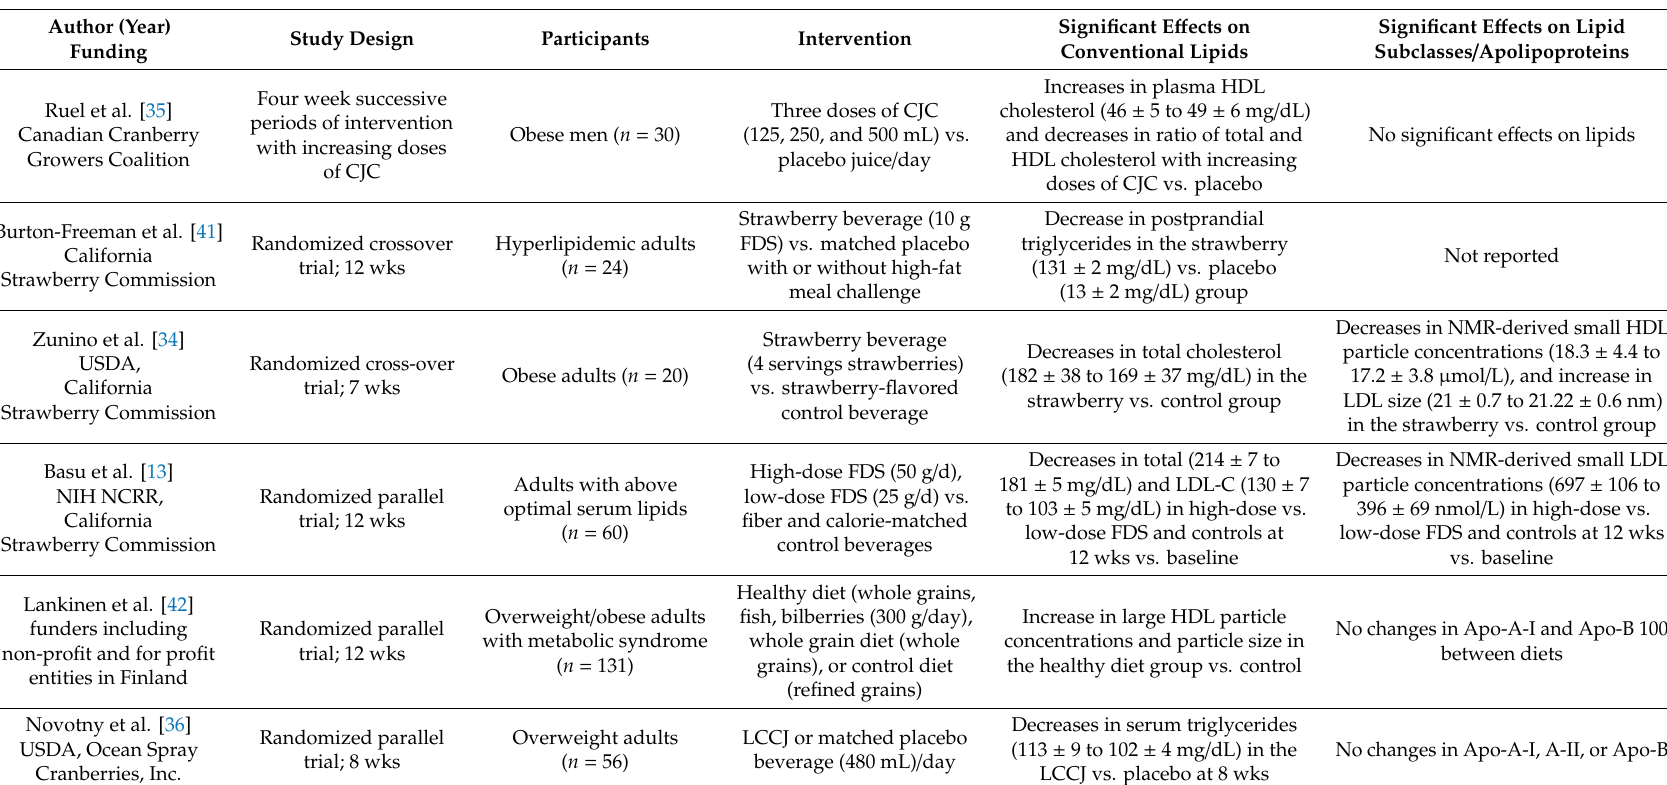
Table 2. E ff ects of dietary berries (whole fruit, juice, or freeze-dried berries) on serum lipids: clinical